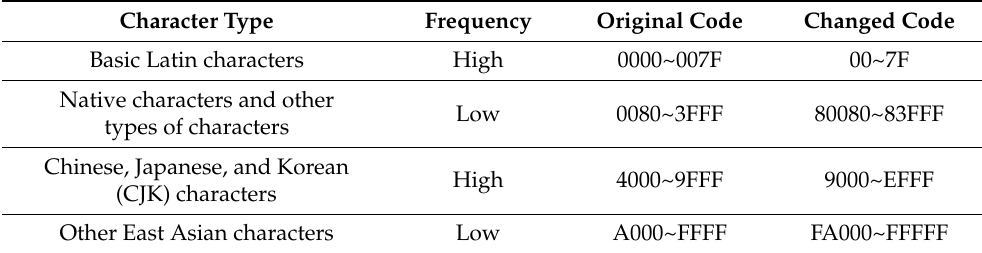
Table 1. The original UTF-16BE and changed